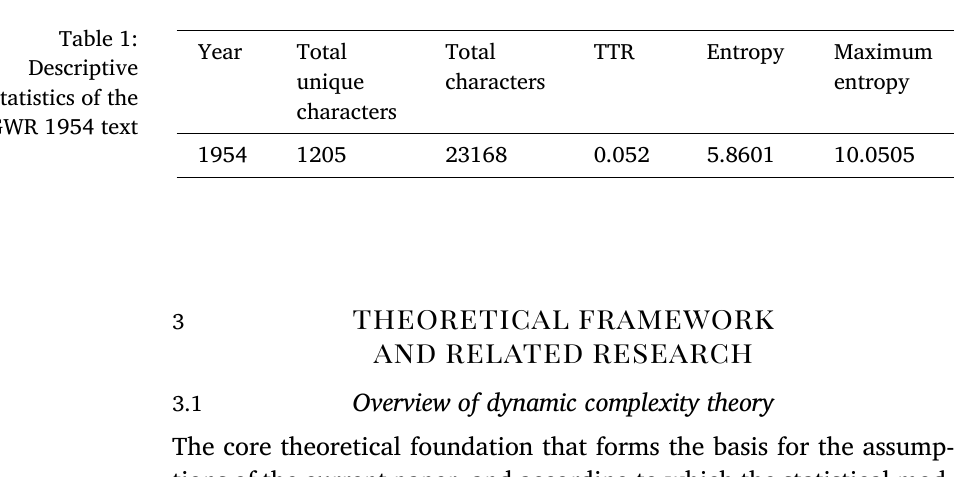
Figure 1: Frequency distribution plots of CGWR 1954 text vides the corresponding frequency plots, where the left plot is in the original scale, and the right plot is scaled by the natural